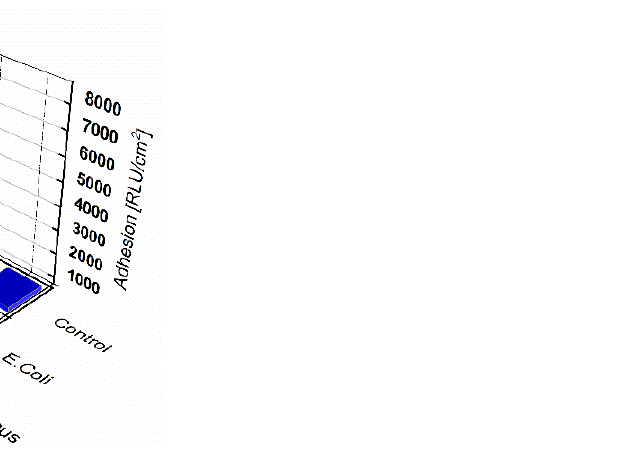
Figure 8. Adhesion [RLU/cm 2 ] of bacterial strains to glass surface after 6-day incubation. DMSO (solvent); HESP (aglycone flavonoid); HABH (hesperetin hydrazone); CuHABH (complex Cu(II) with HABH).